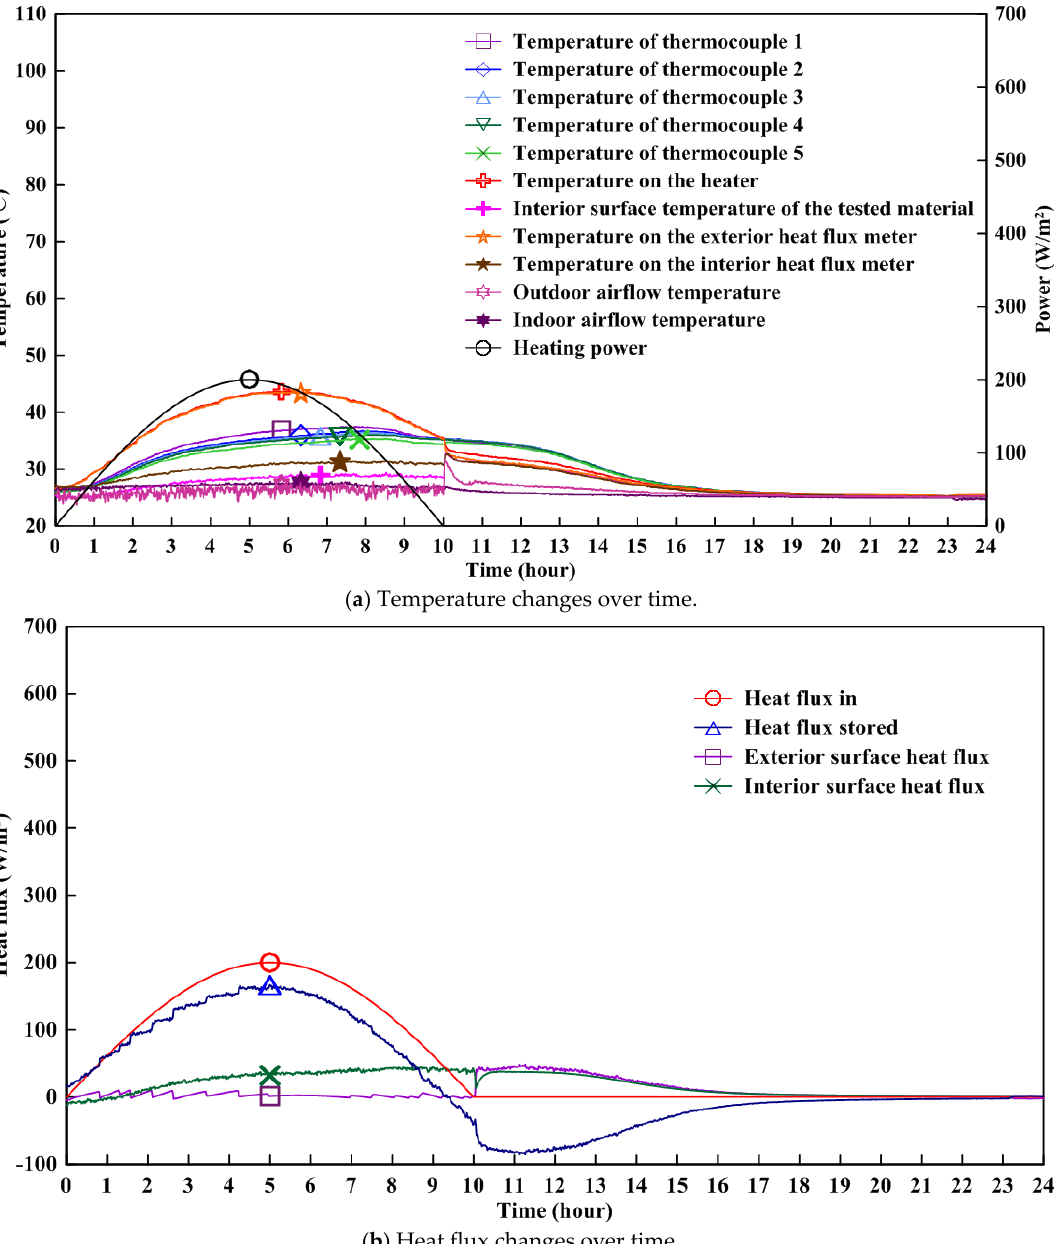
Figure 3. Heat transfer behavior of the tested module ( T m = 37 °C, G s,o = 200 W/m 2 ).